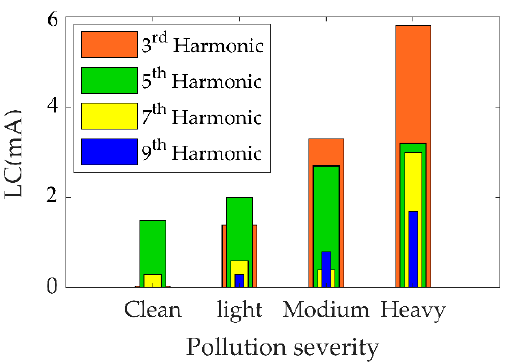
Figure 8. Odd harmonics of leakage current under pollution grading [2]. Table 3. LC characteristics for insulators under different contamination degree for uniform distri- bution. Table 3 provides the test results of the LC harmonic components’ values (magnitude I m , harmonics, THD, and phase shift angle φ ) for different pollution levels under uniform pollution distribution for all investigated conditions. Under the clean condition, the 5th and 7th harmonics were greater than the 3rd harmonic. Furthermore, there were no signs of flashover. The LC rose marginally as the wetting rate increased when the clean insulators were tested under a specific NSDD. This indicates that wetting the insulator surface caused the flow of the charges from the high-voltage terminal to the ground to rise